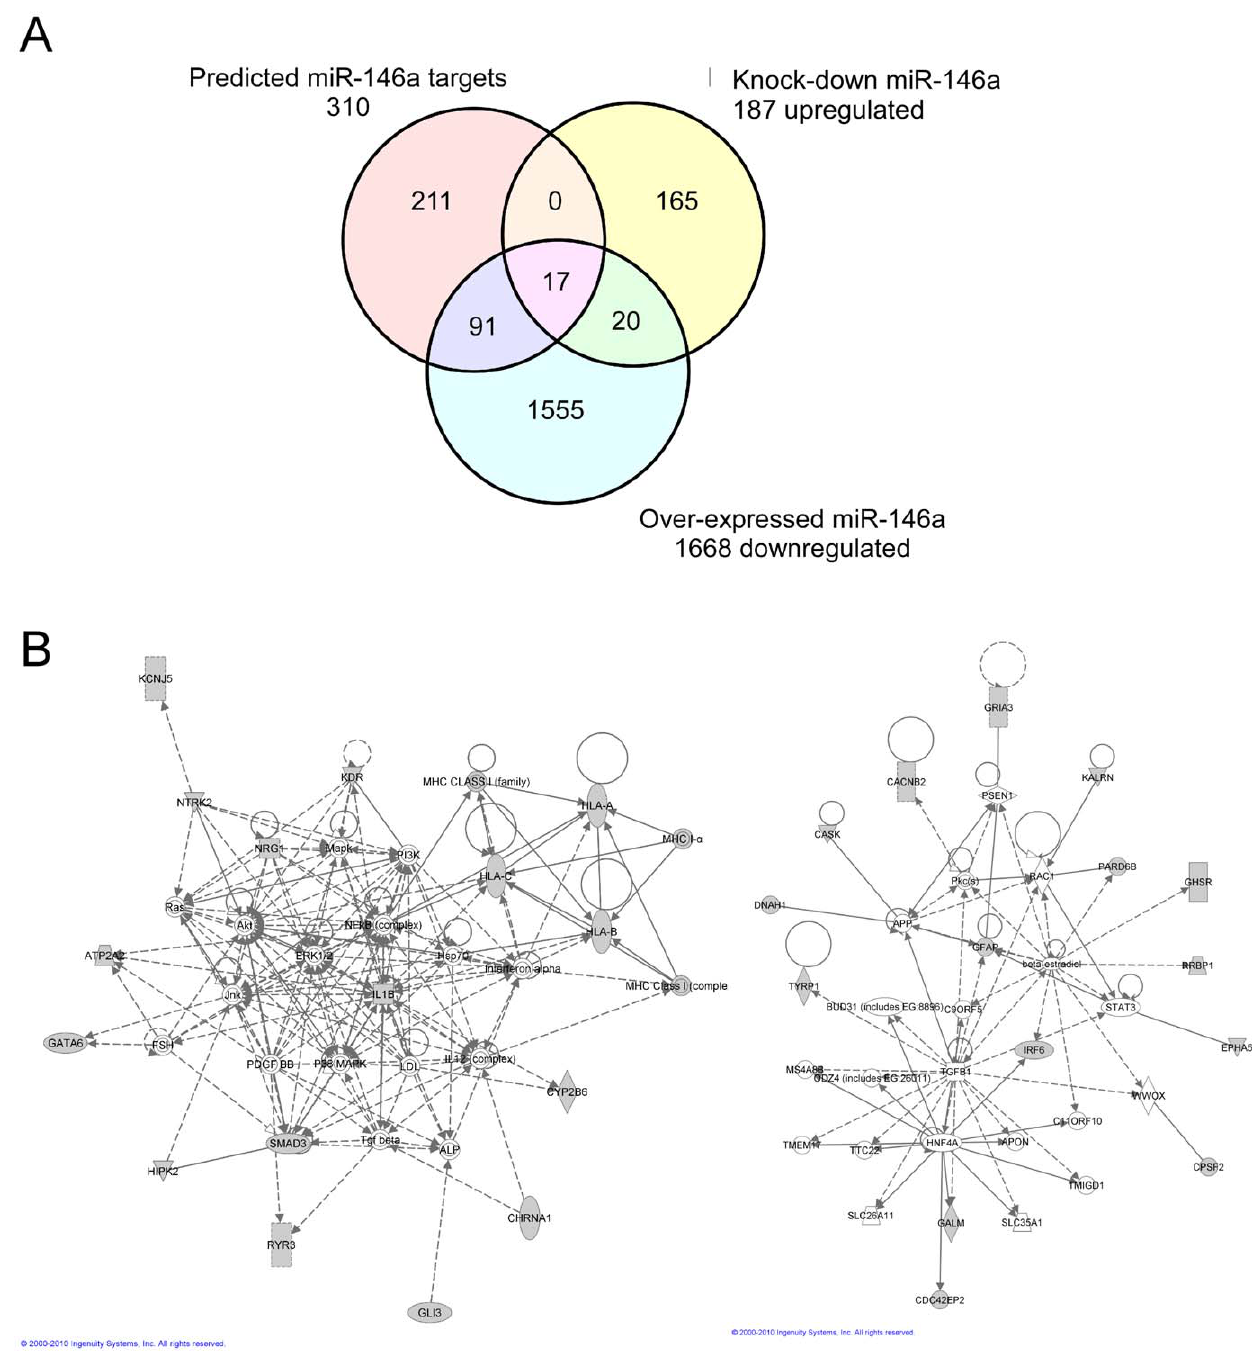
Figure 5. Analysis of genes dysregulated by over-expression, or knock-down of miR-146a in resting EOC 13.31 cells using either miRNA mimics or anti-miRs. A. Venn diagram to show the intersection between genes down-regulated by miR-146a over-expression, up- regulated on miR-146a knock-down and those targets bioinformatically predicted using the TargetScan 5.1 program and IPA software. B. Networks showing the interactions between several predicted miR-146a target genes. Shaded grey are those genes also bioinformatically predicted using the TargetScan 5.1 program and IPA software.